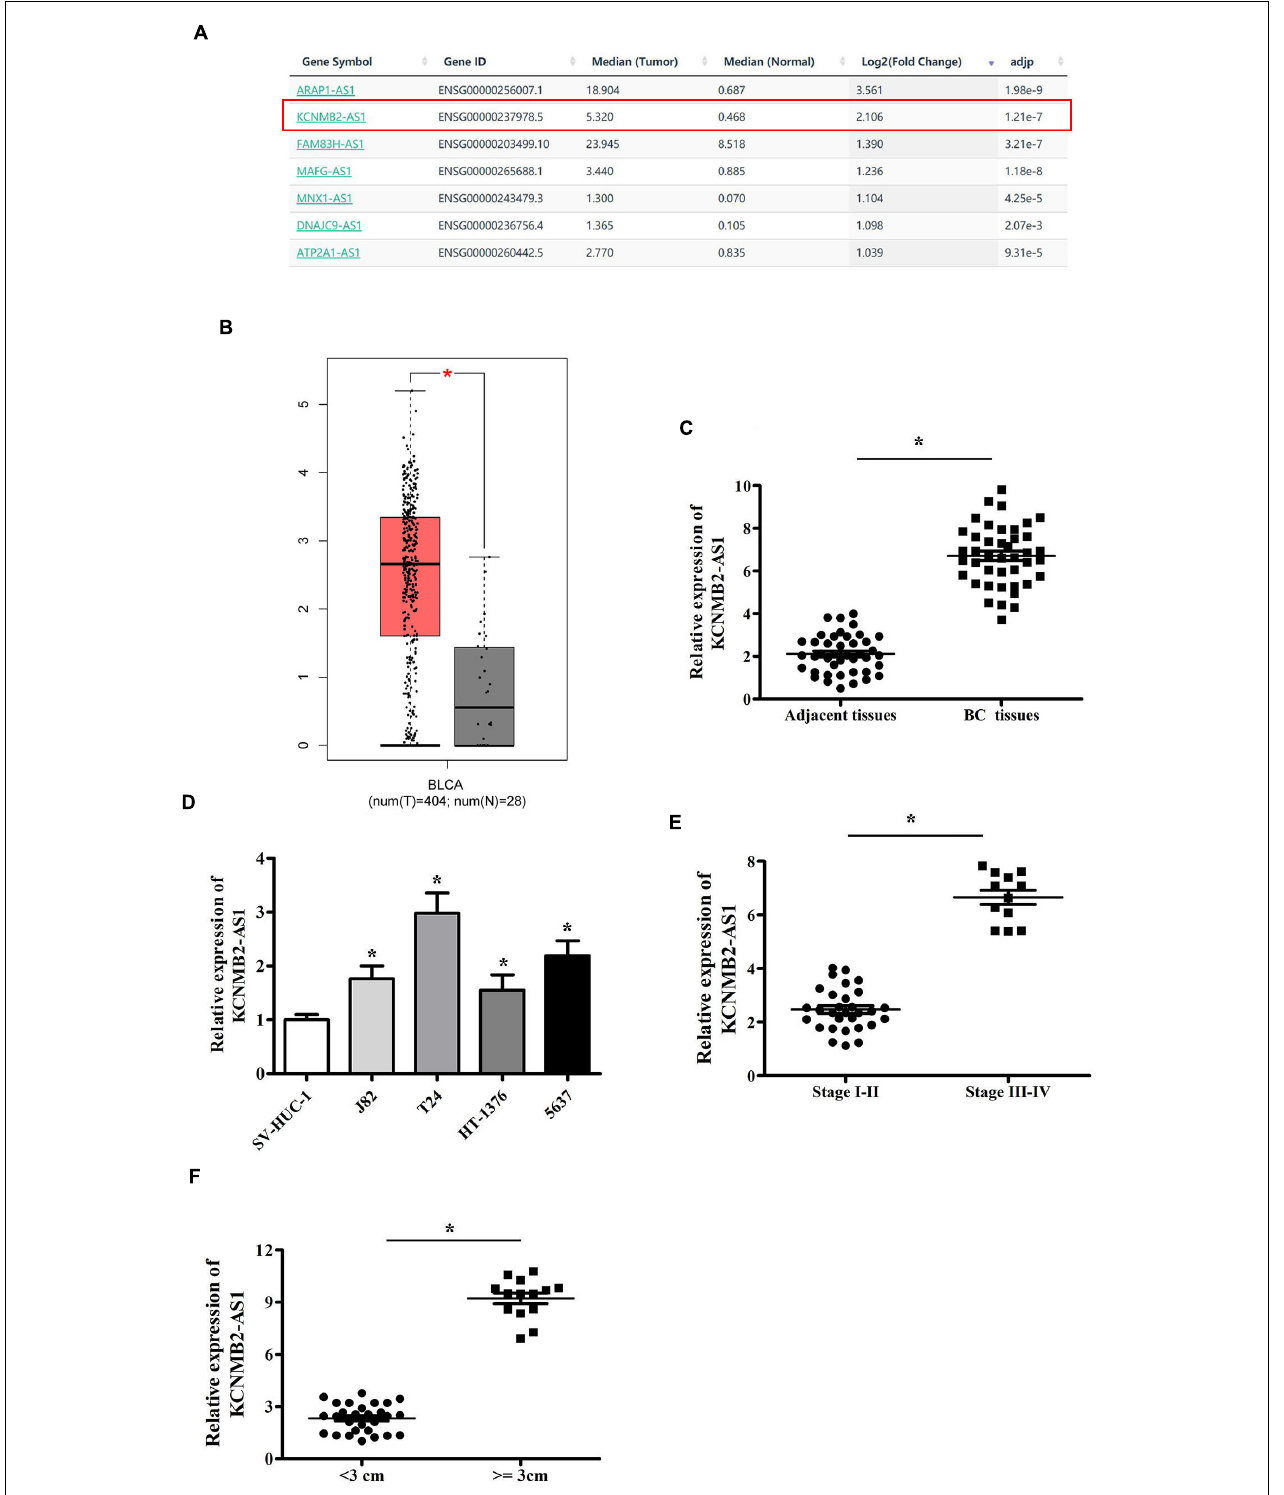
FIGURE 1 | KCNMB2-AS1 was overexpressed in BC. (A,B) KCNMB2-AS1 upregulated in the BC tissues was chosen from GEPIA database. (C) Increased expression of KCNMB2-AS1 in BC tissues compared with adjacent non-tumor tissues. (D) KCNMB2-AS1 was upregulated in BC cell lines. (E) Upregulated expression of KCNMB2-AS1 was associated with advanced stage. (F) KCNMB2-AS1 expression significantly increased in the group with larger tumor size. Data were showed as mean ± standard deviation. * P < 0.05.